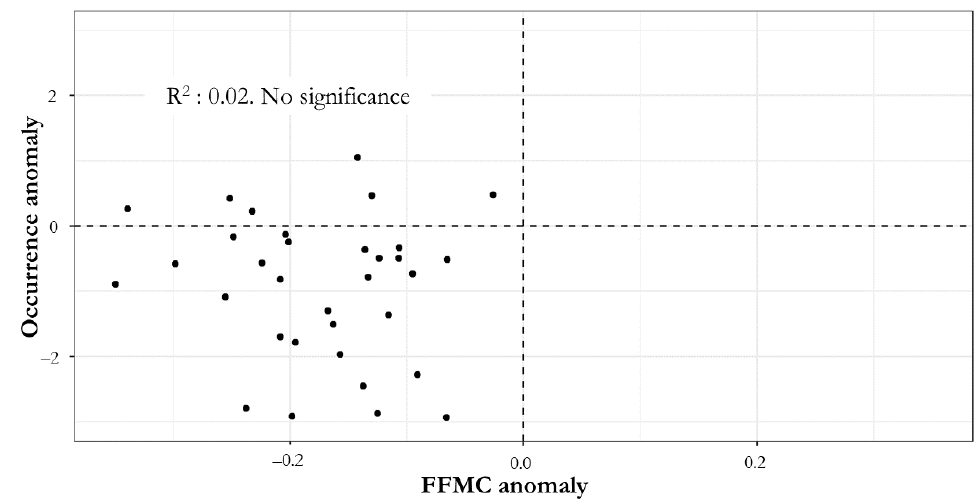
Figure 4. Relationship Between FFMC Anomalies and Occurrence at the Communal Level (Selected Communes).